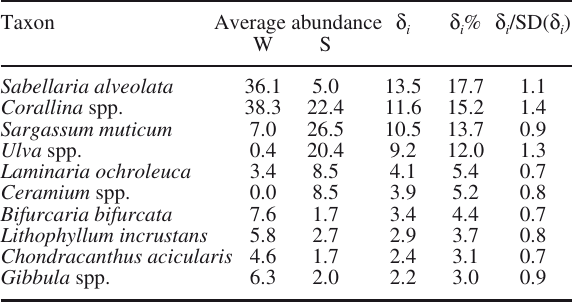
Table 2. – Contribution ( δ ) of individual taxa from rock pool as- i semblages to the average Bray-Curtis dissimilarity between winter (W) and summer (S). Only taxa contributing ≥ 3% of percentage dissimilarity are included. Values of δ /SD( δ ) ≥ 1 indicate that the i i contribution of a taxon to percentage dissimilarity was consist- ent among pairwise comparisons of samples between winter and